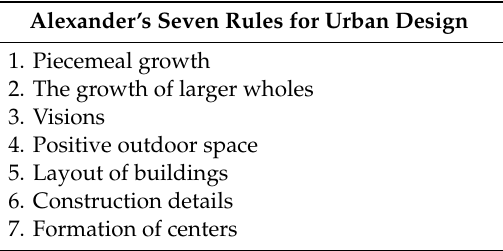
Table 4. Alexander’s seven rules for urban design [7] (pp.